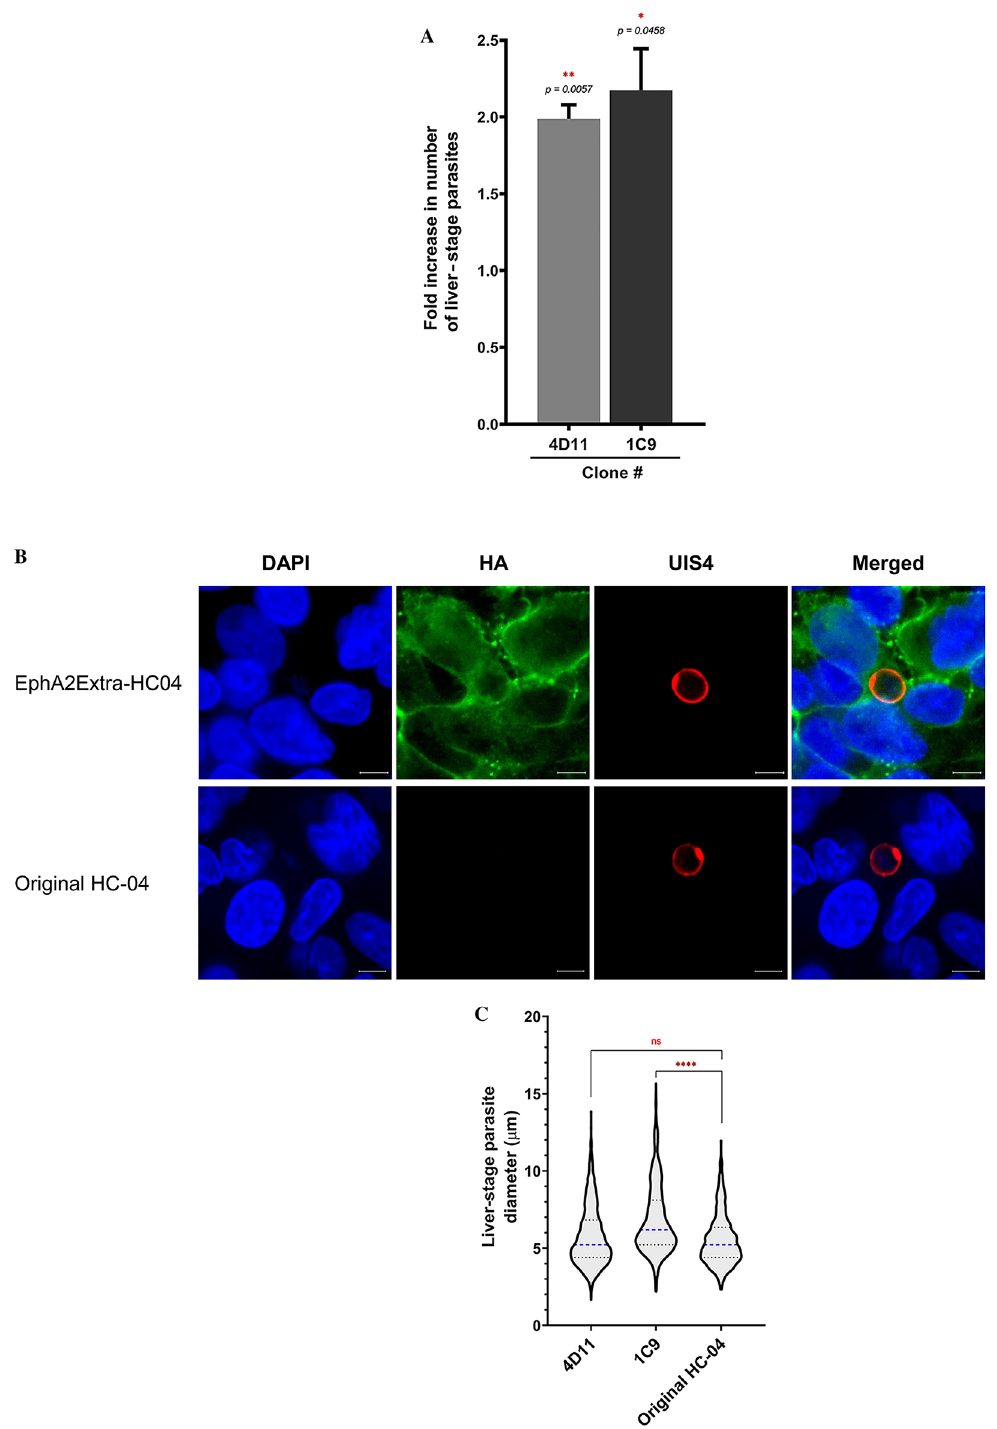
Figure 4. EphA2Extra-HC04 cells enhanced P. vivax liver-stage infection. ( A ) Fold increase of P. vivax infection of the two EphA2Extra-HC04 clones relative to the original HC-04. Error bars represent S.E.M. of 8 biological replicates. The p -value for two-tail paired t-test between EphA2Extra-HC04 cell clones and original HC-04. ( B ) P. vivax -infected EphA2Extra-HC04 (top) and original HC-04 (bottom) were labeled with a HA-tag antibody (green). Liver-stage parasites were labeled with a UIS4 antibody (red). Nuclei were stained with DAPI (blue). The scale bar represents 5 μm. ( C ) The size distribution of liver-stage parasites in each cell line. The diameters of intrahepatic parasites on day 4 post-infection were pooled from eight P. vivax clinical isolates. Dashed lines represent the medians; dotted lines delimit the interquartile ranges. ****Indicates a p -value < 0.0001 and ns indicates a non-significant test result ( p = 0.0761) by the Mann–Whitney test between the indicated